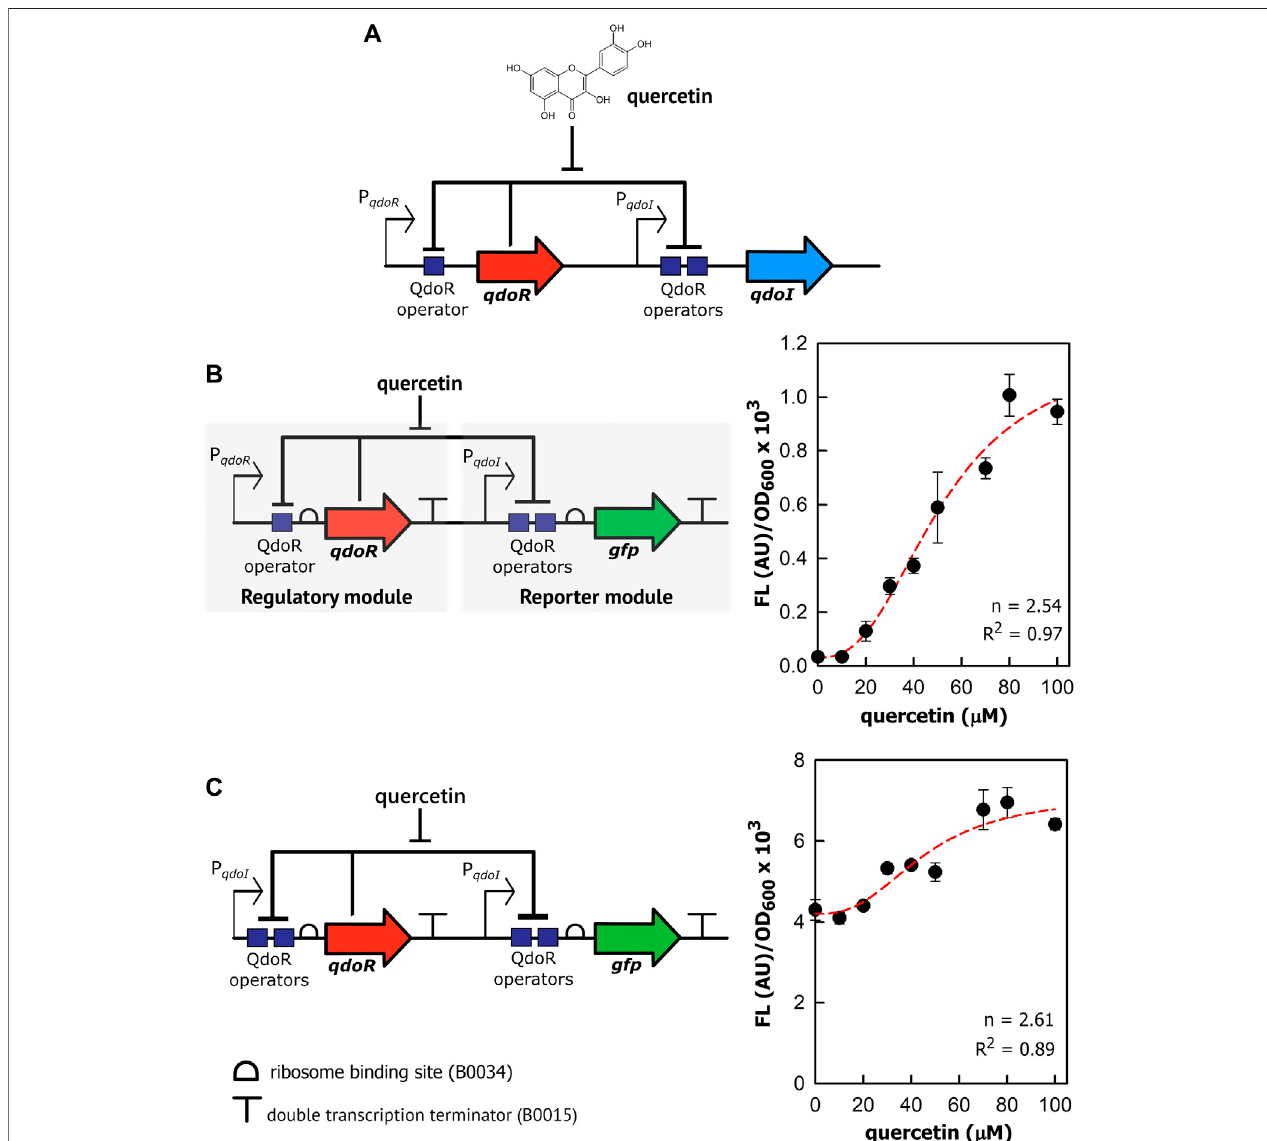
FIGURE1| QuercetininducesgeneexpressioninthereassembledgeneticcircuitsrepressedbyQdoR. (A) ThenaturalQdoR/P qdoI systemof Bacillussubtilis .The qdoR expression is self-regulated by QdoR. The P qdoR promoter has one QdoR operator downstream of the RNA polymerase -10 recognition site. QdoR binds to two operators in the P qdoI promoter, repressing qdoI expression. Quercetin binds to QdoR, reducing its af fi nity for DNA and derepressing qdoR and qdoI expression. (B) Genetic circuit constructed with minimal promoters P qdoR and P qdoI controlling qdoR and gfp expressions, respectively. The regulatory module controls the expressionofQdoR,whilethereportermodulecontrolstheexpressionofthereporterGFP. (C) Alternativecircuitwith qdoR undercontrolofP qdoI .Thegraphsattheright of the circuit schemes show the speci fi c GFP fl uorescence in arbitrary units (FL (AU)) normalized by OD 600 of the E. coli culture as a function of quercetin concentration added to the medium. The FL and OD 600 shown in the graphs were measured after 6 h of growth. About that time after induction, FL/OD 600 values were already stable ( SupplementaryFigureS5 ).ThereddashedlinesrepresenttheHillfunction fi ttingtotheexperimentaldata.Thenand R 2 valuesaretheHillcoef fi cientandcoef fi cientof determination, respectively, for each plot. Note that the genes and regulatory elements in the circuit schemes are not to scale. The sequences of the genetic part assembled in the circuits are provided in Supplementary Table S1 . The experiments were conducted with biological triplicates. After induction, the fl uorescence of each replicate was measured once at speci fi ed times. The error bars represent the standard